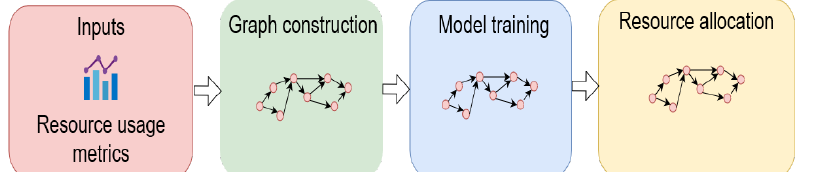
Figure 5. General procedure for resource-allocation algorithms using GNNs for microservice-based cloud